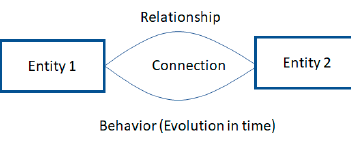
Figure 2. Visual representation of a fundamental triad (named